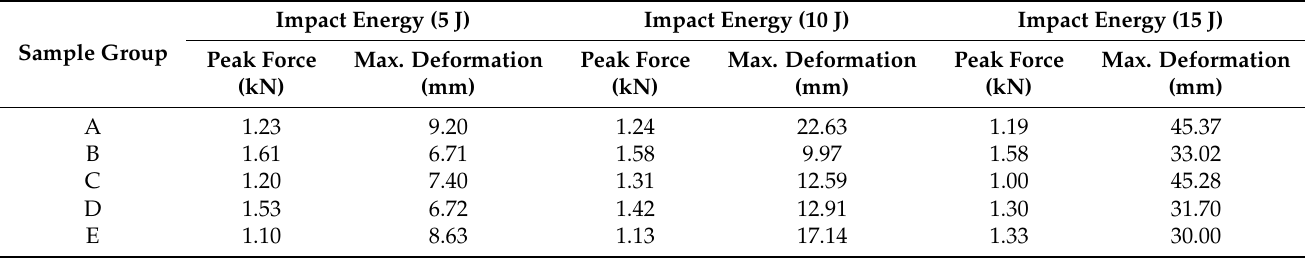
Table 2. Maximum force and deformation under the impact energies of 5 J, 10 J, and 15 J. Impact Energy (5 J) Impact Energy (10 J) Impact Energy (15 Sample Group Sample